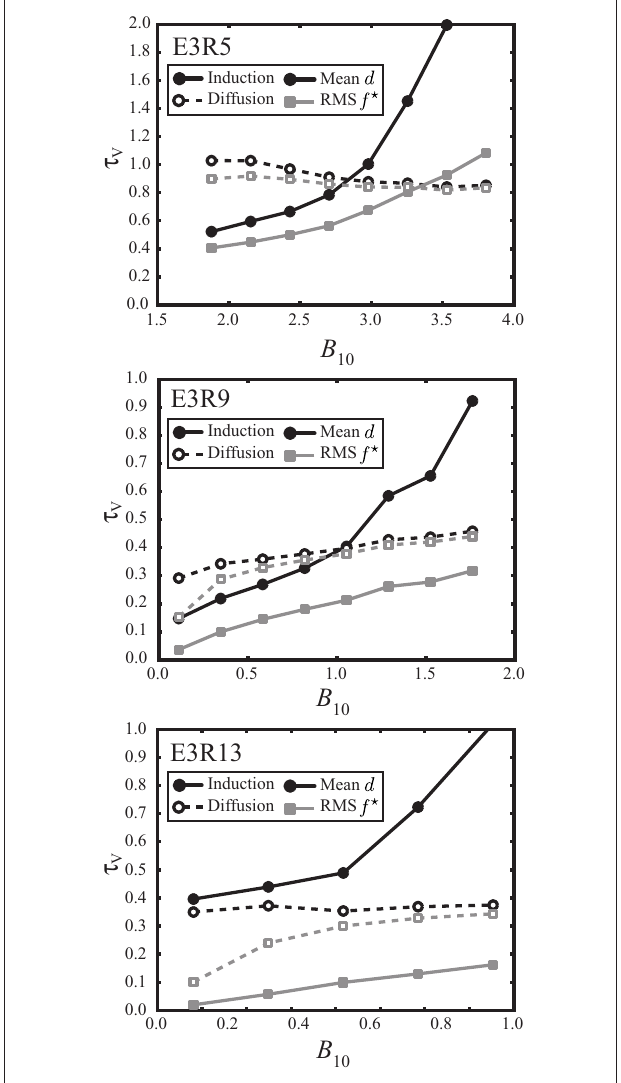
FIGURE 12 | Time scales τ V for the cases with τ > τ c depicted in Figure 11 (see the text for more explanation). All quantities in dimensionless